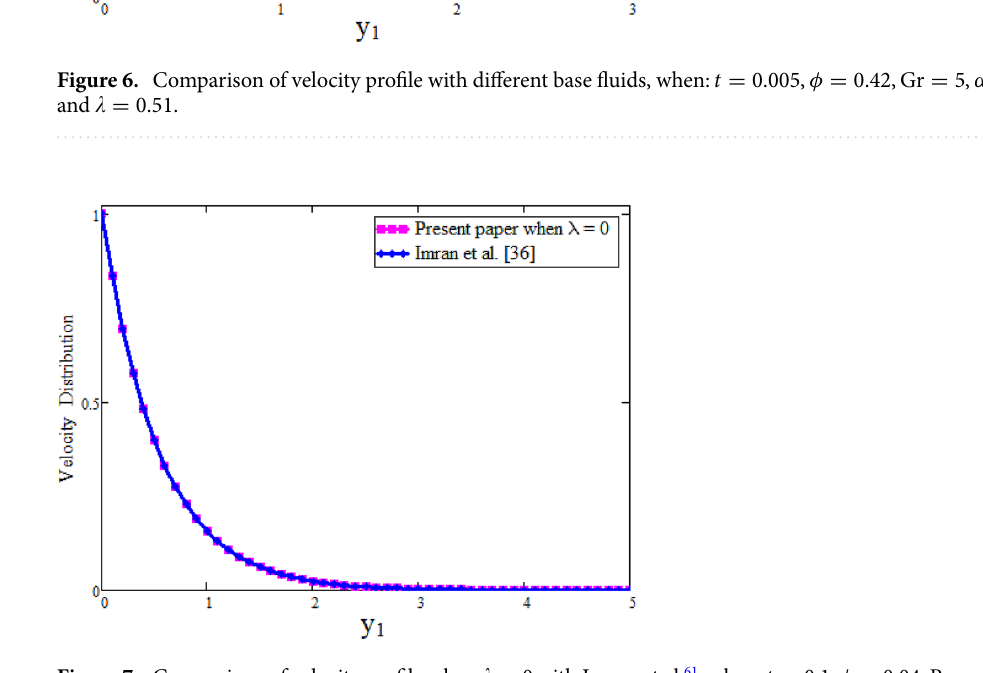
Figure 7. Comparison of velocity profile when (cid:31) = 0 with Imran et al. 61 , when: t = 0.1 , φ = 0.04 , Pr = 6.2 , Gr = 0.1 and α =